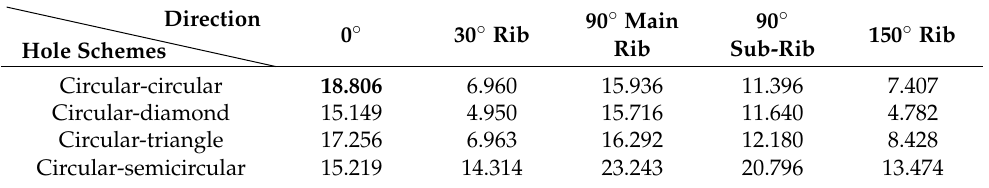
Table 2. Tensile strength of performance-optimized multi-axial geogrid with different holes (KN/m).